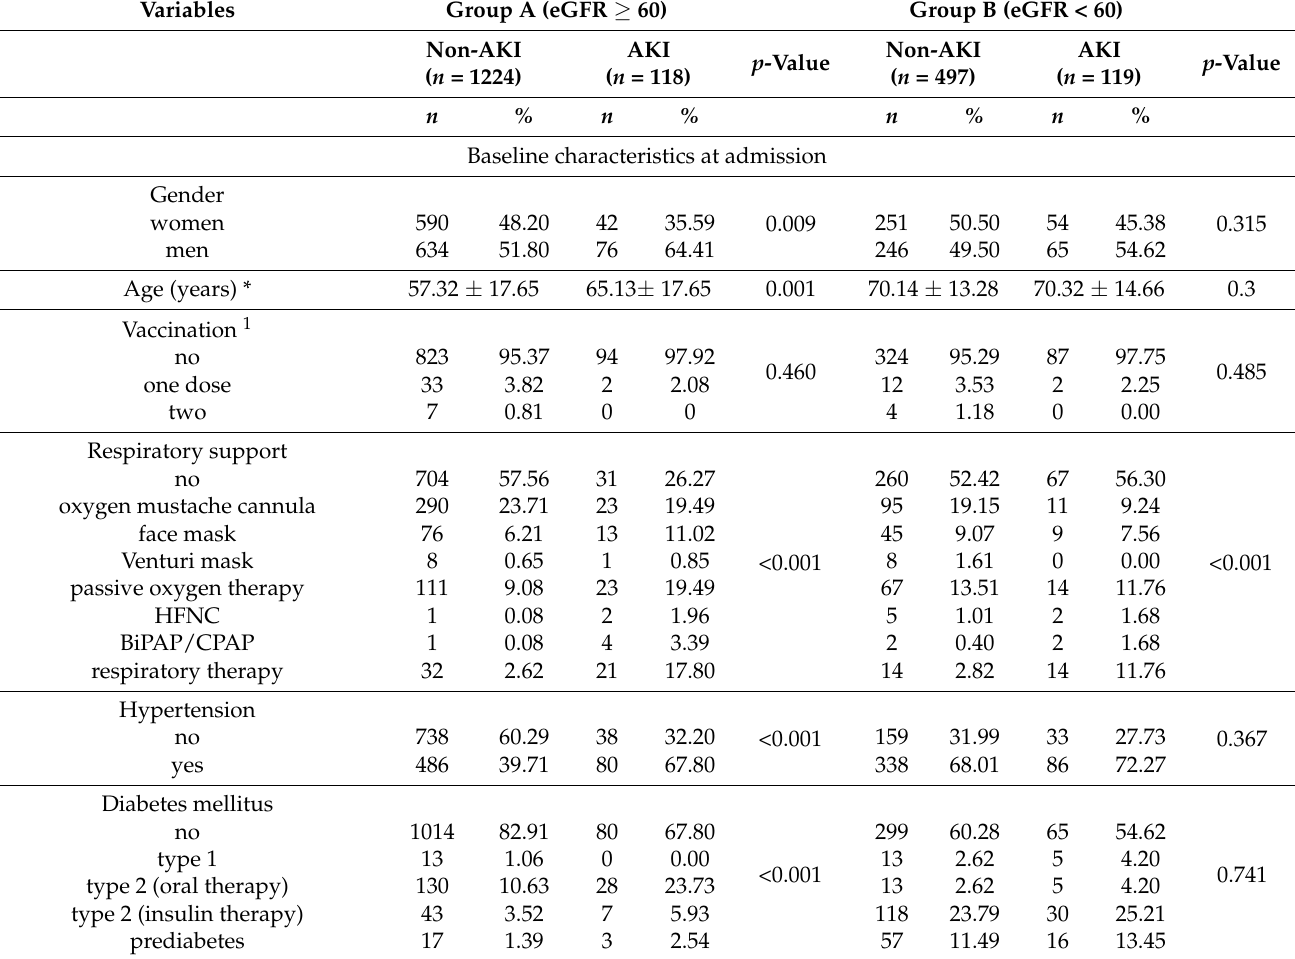
Table 9. AKI in COVID-19 patients: Comparison of two